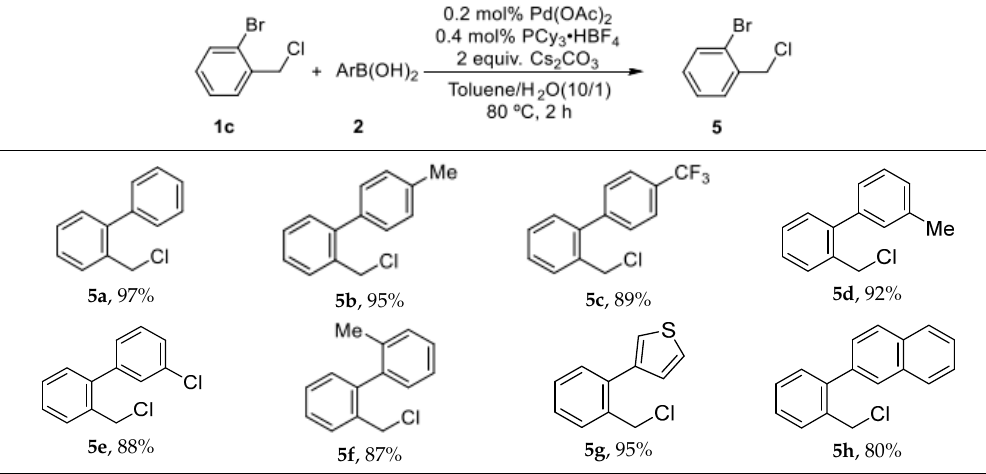
5e , 88% 5f , 87% 5g , 95% 5h , 80% a Reaction conditions: 1-bromo-3-(chloromethyl)benzene 0.30 mmol, arylboronic acid 0.33 mmol, 0.2